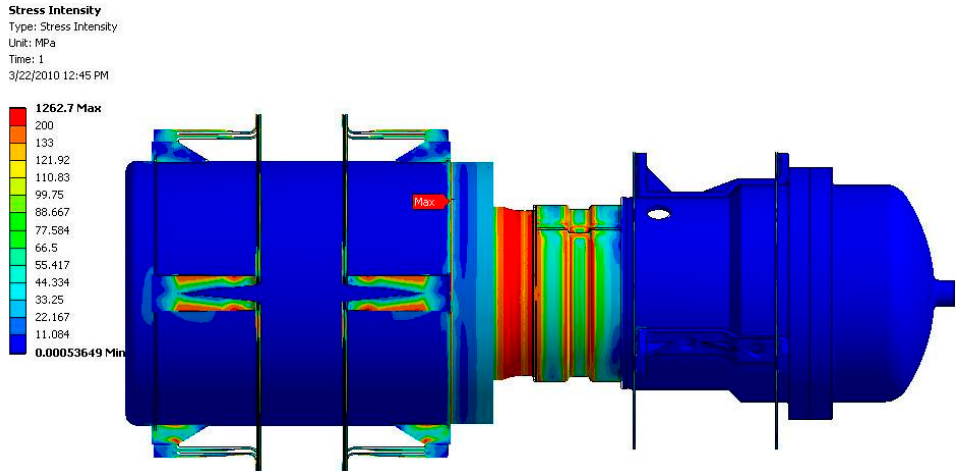
Figure 7. Stress distribution in engine/TES System.